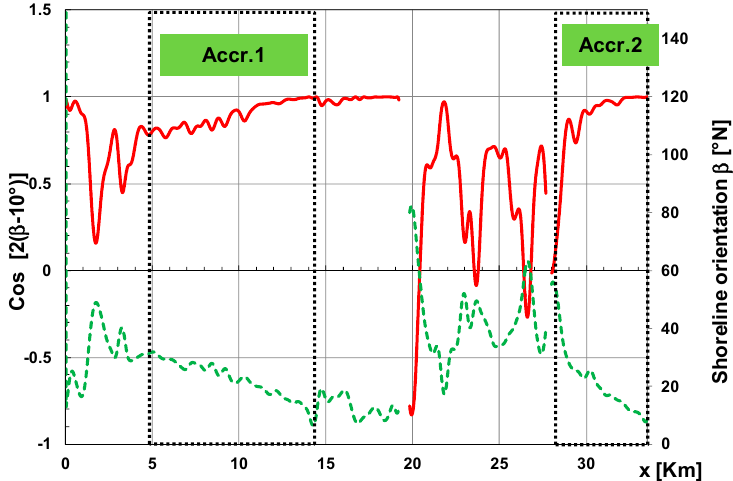
Figure 18. Cosine term of Equation (9) in red and shoreline orientation (in green).